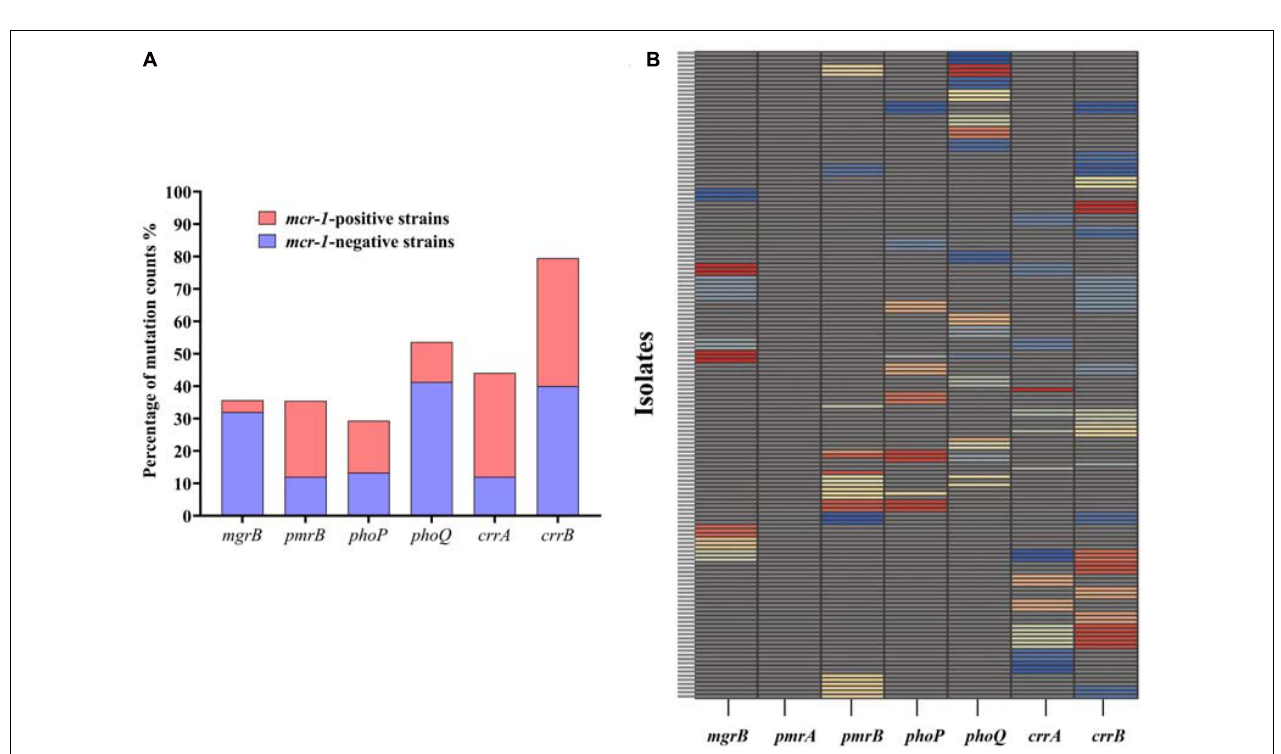
FIGURE 2 | Distributions of colistin minimum inhibitory concentration (MIC) values among E. coli and K. pneumoniae mutants after induction of colistin resistance in vitro . (A) Data for 90 mcr-1 -positive and 60 mcr-1 -negative E. coli derivatives. (B) Data for 81 mcr-1 -positive and 75 mcr-1 -negative K. pneumoniae derivatives. E. coli data are indicated in blue, and K. pneumoniae data are indicated in orange.